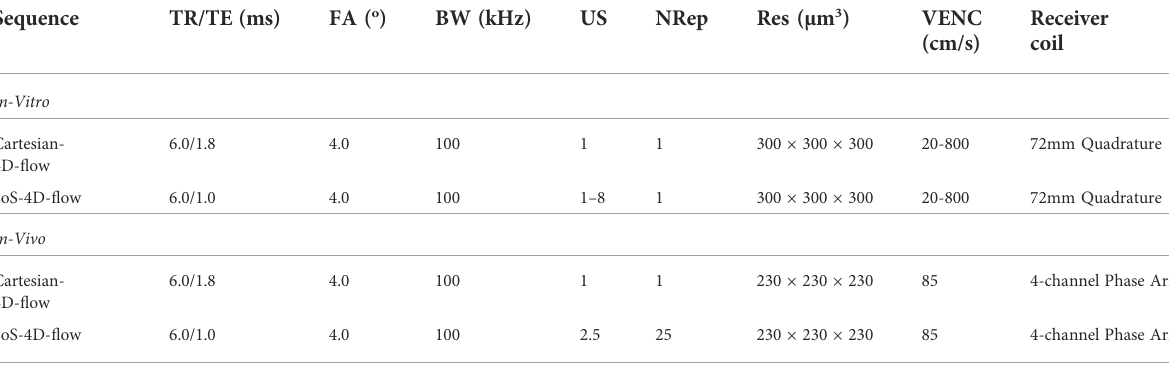
TABLE 1 Summary of the applied sequences and their corresponding